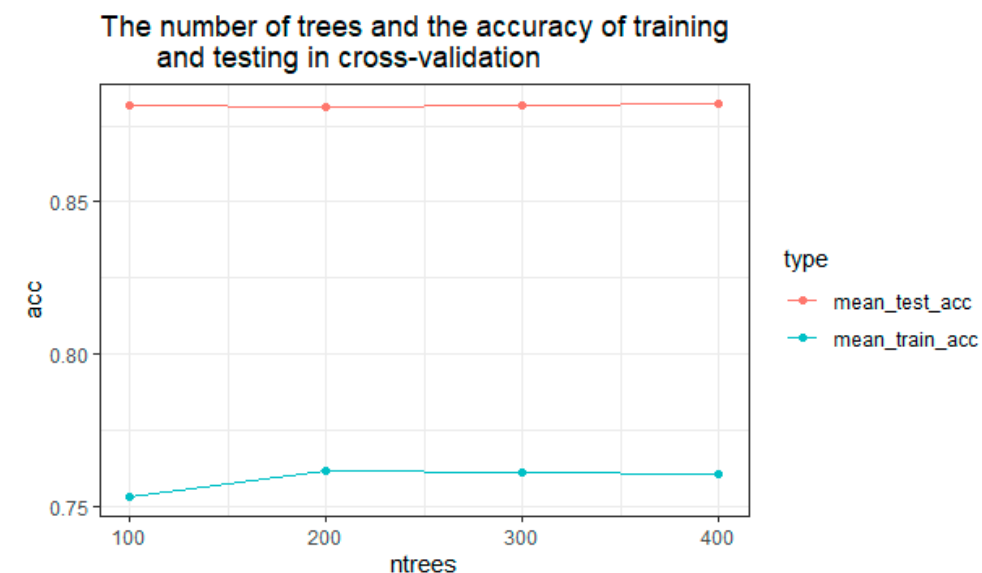
Figure 7. Comparison charts of the predictive and actual values of the SVM (part of the sample).